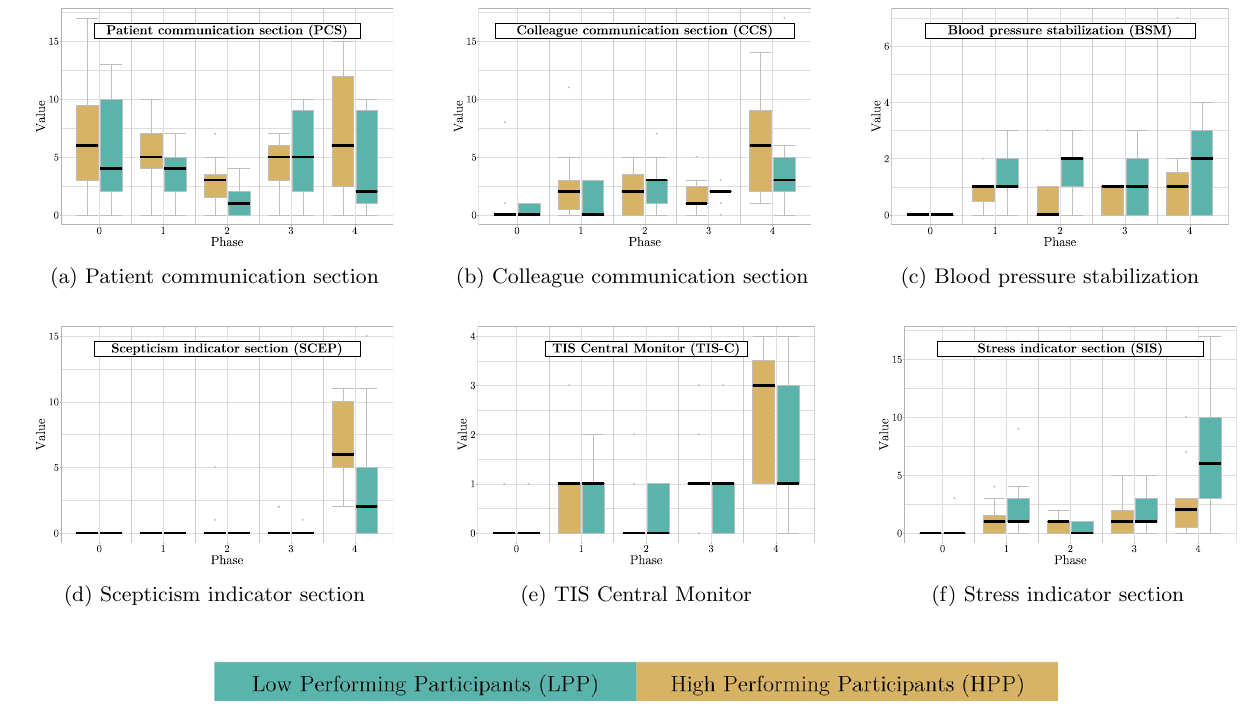
Figure 2. Behavioral patterns of the participants—This figure presents the measured codes, normalized and accumulated into patterns comparing both HPP and LPP through the five phases. Please mind the different scale of Y-axis, Phase 0 was the Acclimation